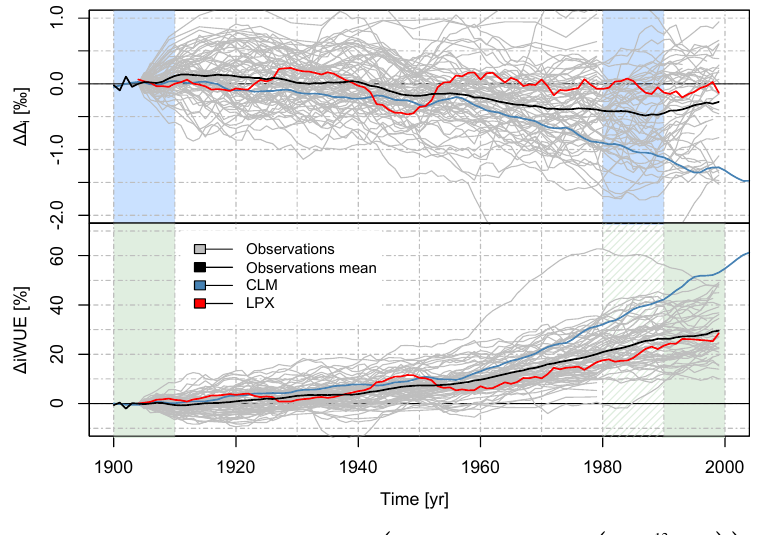
Figure 7. 20th century changes in the discrimination (cid:49) i of C3 trees on tree rings (black) and modeled by CLM4.5 (blue) and LPX (red). Observations are represented by the average over all measurements (see Table A1), models by the average of the mean grid-cell signature of C3 trees and for all model grid cells where measurements are available. Values are given with respect to the decade 1900–1909; the background colors indicate the respective decades investigated for changes in discrimination (Figs. 8, 9, 10) and iWUE (Figs. 10, 11, 12). Absolute values of iWUE for the decade 1900–1909 are 78 for the observation and LPX-Bern and 50 for CLM4.5. Standard deviations calculated over all observations of century-scale changes (1980s minus 1900s) are 0.72 for (cid:49) i and 9.76 for